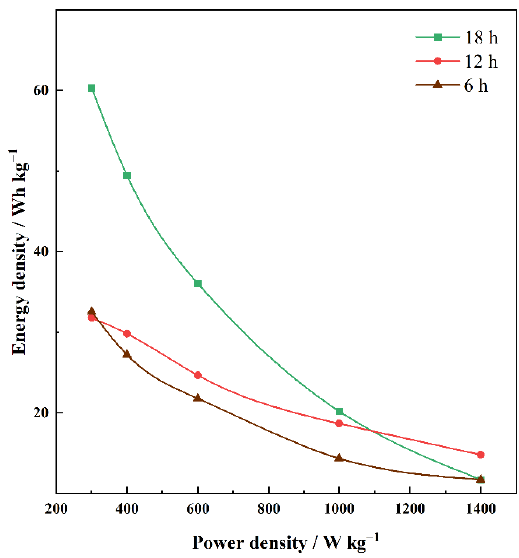
Figure 12. Ragone plots ( E vs. P ) of ZnMn 2 O 4 spinel produced for 6 h (brown), 12 h (red), and 18 h (green).